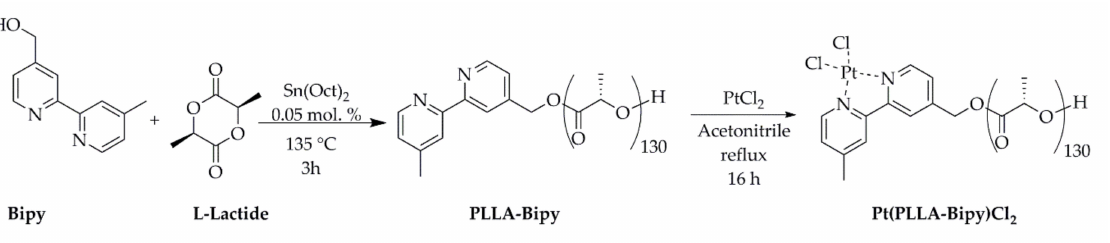
Figure 2. Pathway for the synthesis of Pt(PLLA-Bipy)Cl 2